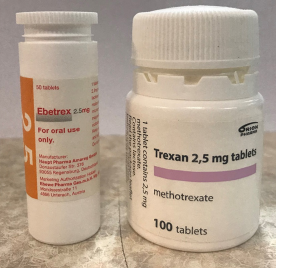
Figure 1. MTX tablets, two different models from two drug companies.